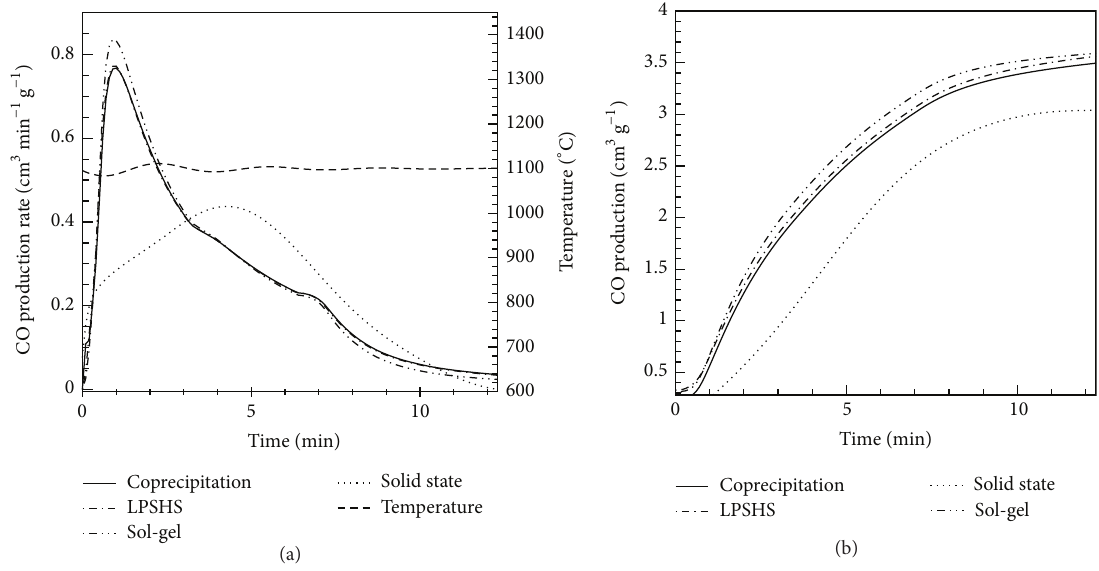
Figure 5: CO production (a) rate and (b) yield versus time during the oxidation step of the 5th